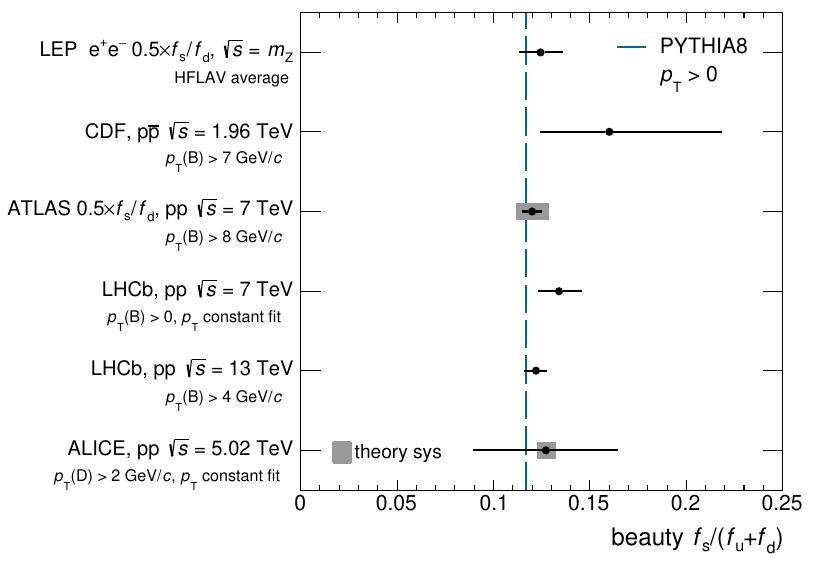
Figure 11 . Beauty-quark fragmentation-fraction ratio f s / ( f u + f d ) from non-prompt D-meson mea- surements compared with previous measurements performed by the CDF [92], LHCb [37, 44], and ATLAS [20] Collaborations and to the average of LEP measurements [93]. The total experimental uncertainties (bars) and the theoretical uncertainties (shaded boxes) are shown. The experimental measurements are compared to the value obtained from PYTHIA 8 simulations with Monash-13 tune